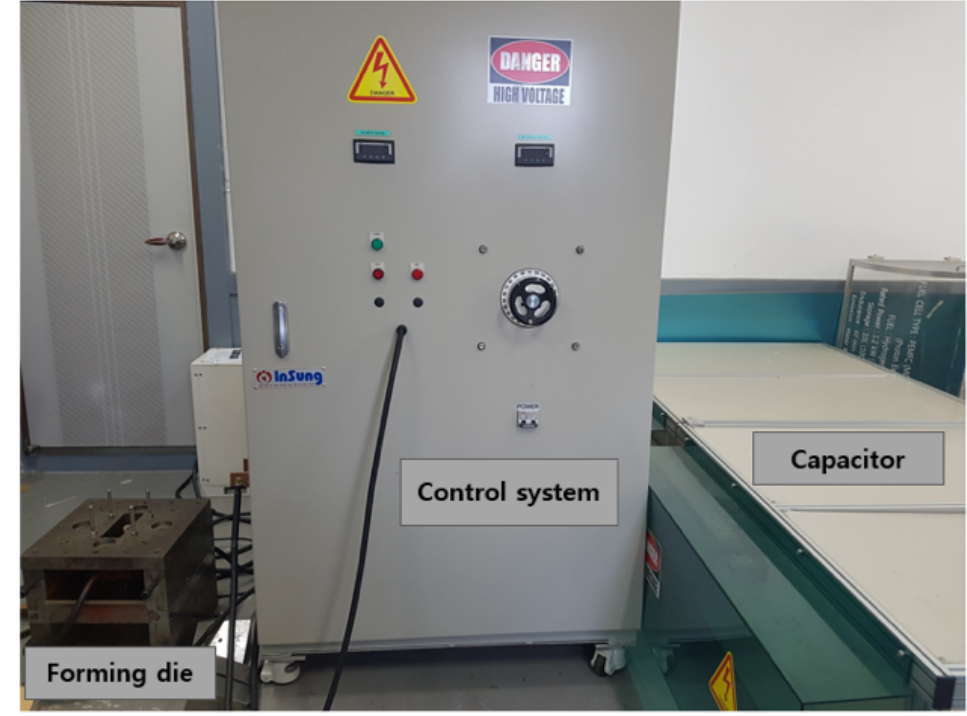
Figure 1. EMF equipment